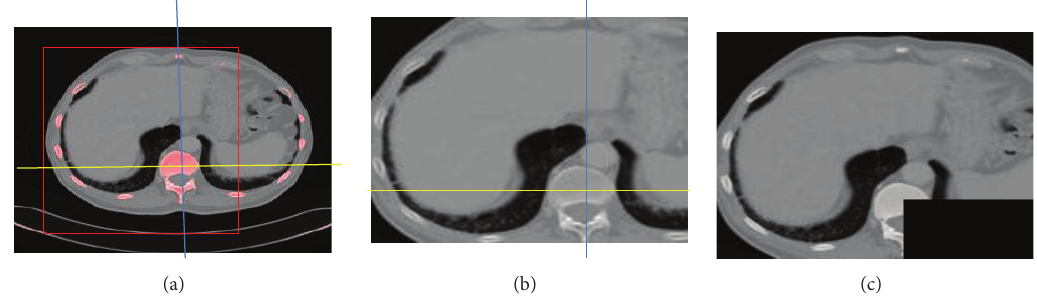
Figure 4: ROI extraction from 3D-CT data volume.